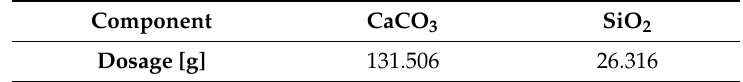
Table 1. Chemical composition, in g, for 100 g of final T1 C 3 S product, C:S = 3.0 [27]. Component